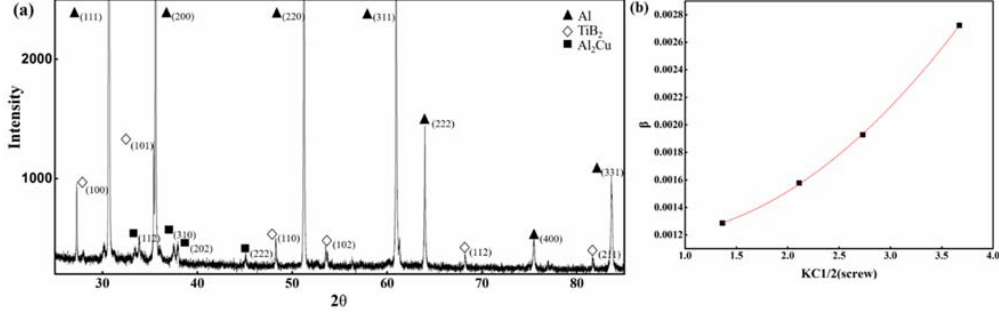
Figure 3. ( a ) Synchrotron X ‐ ray diffraction patterns of the TiB 2 ‐ reinforced Al–3.8Cu–1.3Mg composite powder; ( b ) Modified Williamson ‐ Hall plot.